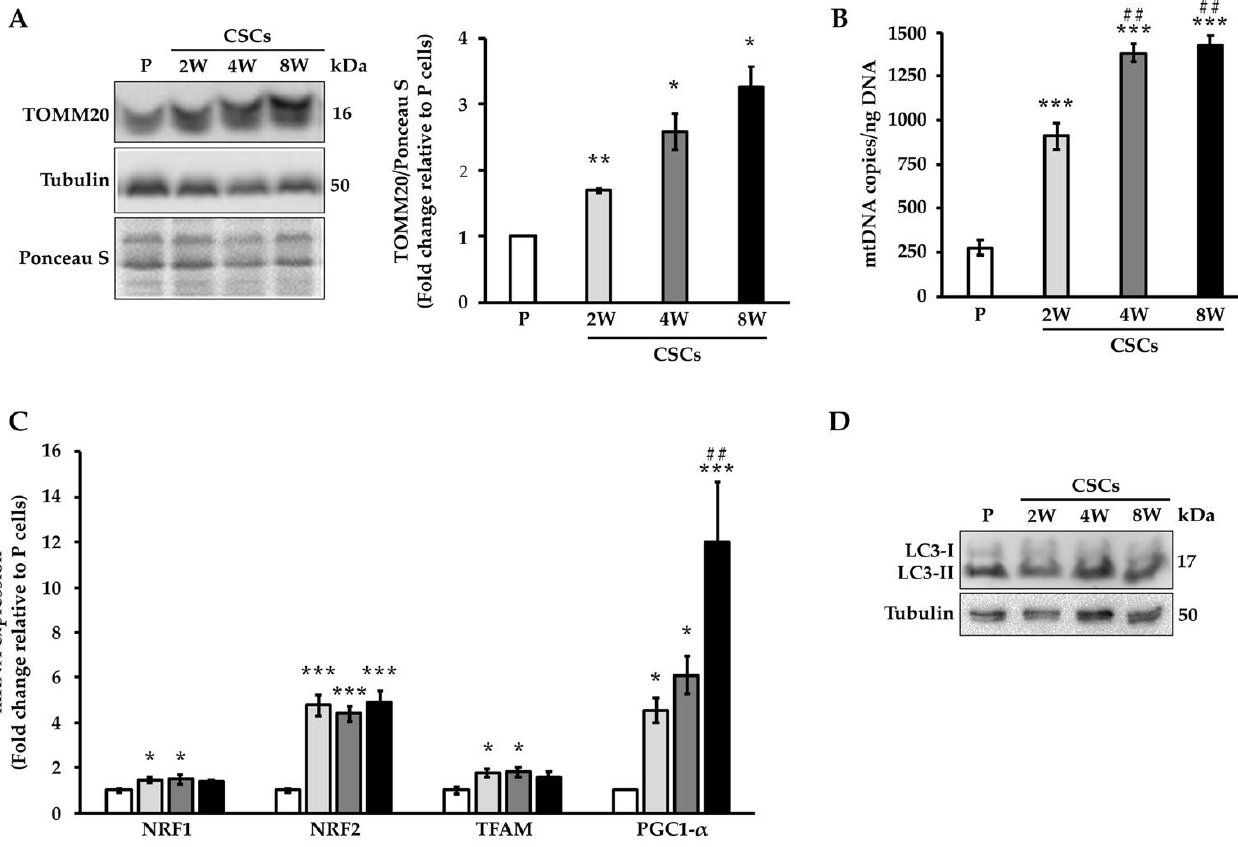
Figure 1. Panc1 cells cultured in the stem-specific medium for 2-, 4-, and 8-weeks exhibited an increase in mitochondrial mass. ( A ) Left panel, representative immunoblot of TOMM20 in Panc1 parental (P) cells and CSCs at 2 weeks (2W), 4 weeks (4W), and 8 weeks (8W) of culture; right panel, densitometry analysis of TOMM20. ( B ) Quantification of mtDNA copies by digital droplet PCR. ( C ) mRNA expression levels of the genes involved in mitochondrial biogenesis in P cells and CSCs. Levels were normalized to SDHA . The values are reported as fold change relative to P cells. ( D ) Representative immunoblot of LC3-II. Histogram legends: white: P cells; light gray: CSCs 2 weeks (2W); dark grey: CSCs 4 weeks (4W); black: CSCs 8 weeks (8W). Bars indicate the mean ± SEM of the indicated samples. Statistical legends: Parental vs. CSCs = * p < 0.05, ** p < 0.01, *** p < 0.001; 2W CSCs vs. CSCs = ## p < 0.01.